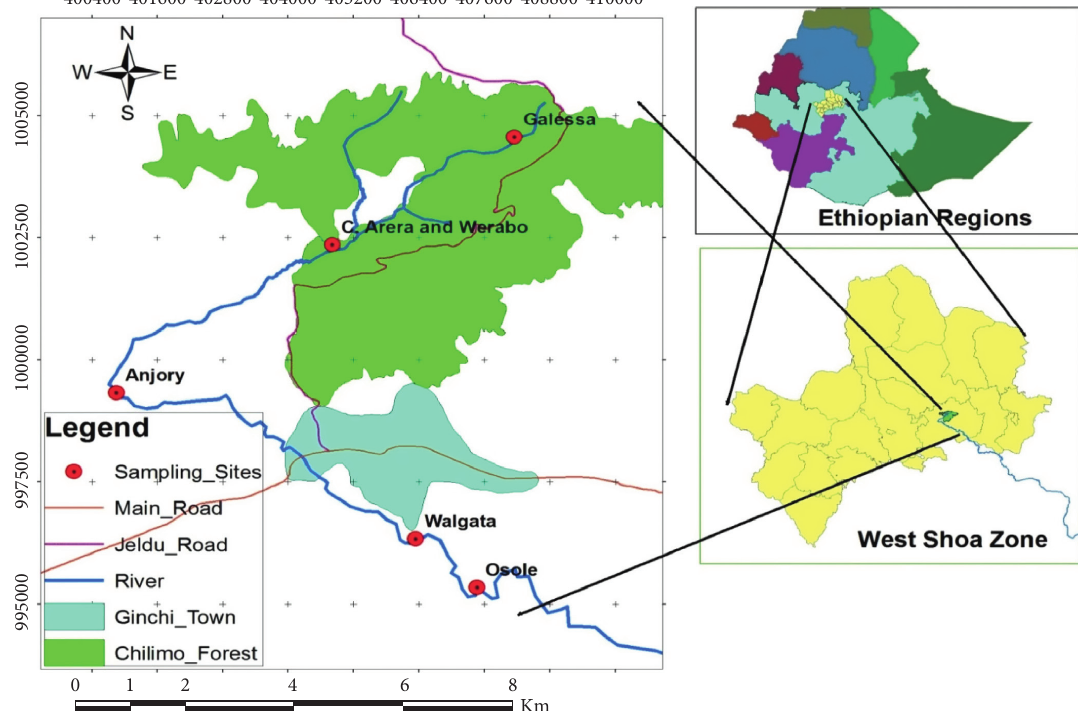
Figure 1: Locations of the study area (Galessa: forest site, Arera: less agriculture, Anjori: high human activities, Walgata: paper mill waste, and Osole: high